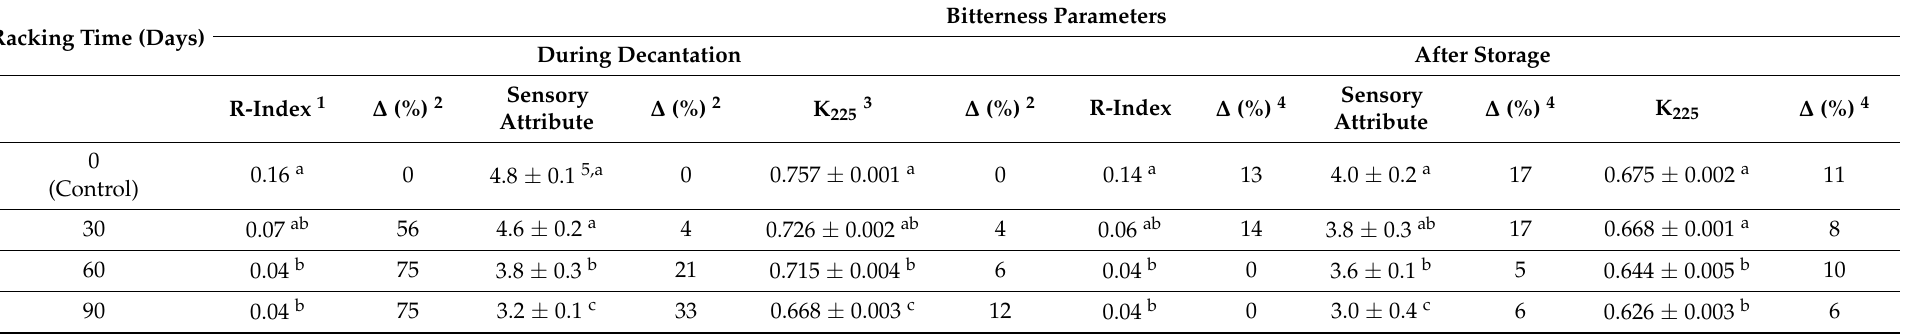
Table 6. Bitterness parameters of Coratina monocultivar EVOO evaluated during the decantation time and after seven months of storage.